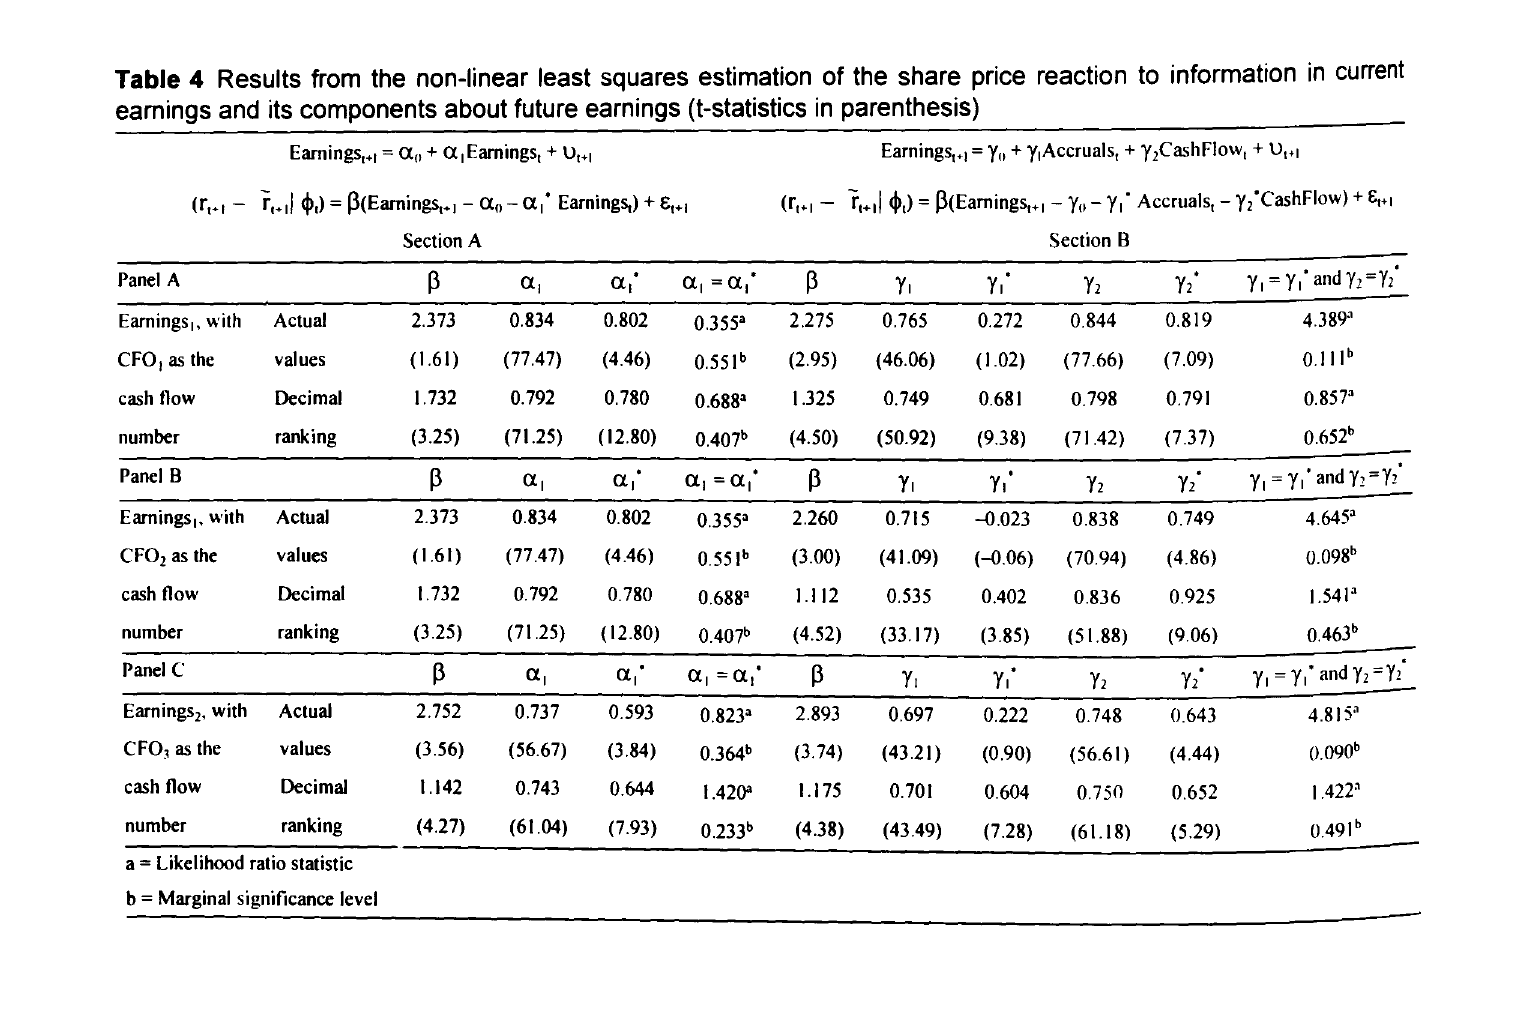
Table 4 Results from the non-linear least squares estimation of the share price reaction to information in current earnings and its components about future earnings (t-statistics in parenthesis) Earnings,.1 = a 0 + a I Earnings, + u,.